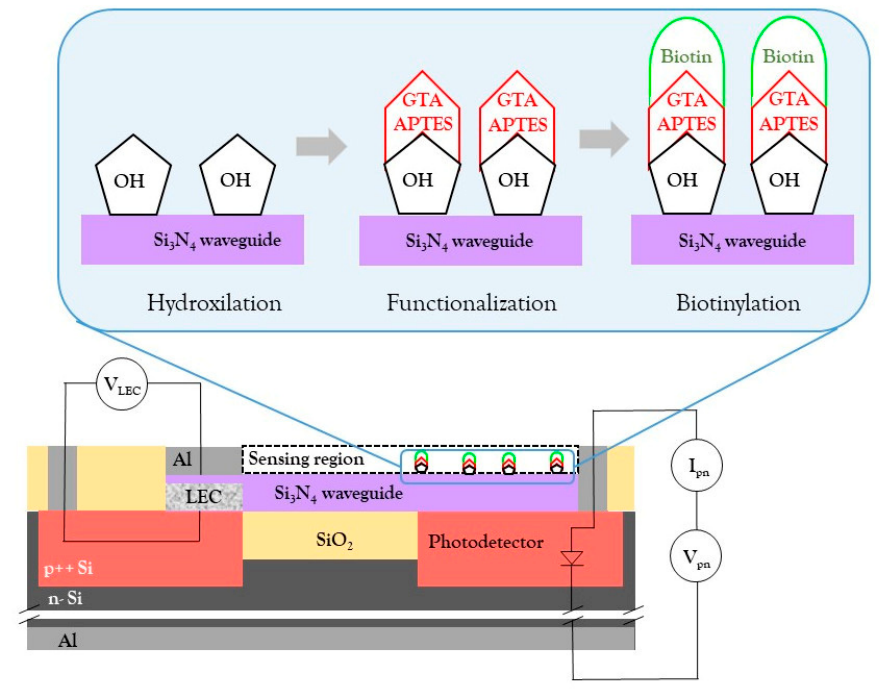
Figure 1. Cross-section of a schematic representation of the electrophotonic system ( bottom ) and the steps for activation, functionalization, and biotinylation of the sensing region on the surface of the Si 3 N 4 waveguide core ( top ).